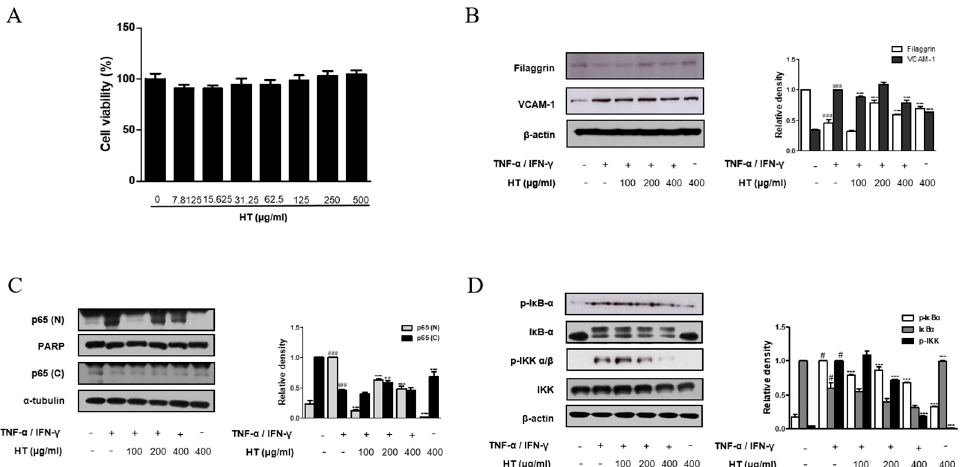
Figure 5. Effect of HT on the expression of filaggrin, VCAM-1 and NF- κ B activation in TNF- α /IFN- γ -stimulated HaCaT keratinocytes. ( A ) HaCaT keratinocytes were incubated with the indicated doses of HT for 24 h, and then cell viability was evaluated by MTT assay. HaCaT keratinocytes were pre-treated with HT for 1 h and then stimulated with TNF- α /IFN- γ (10 ng/mL) for 24 h. Total proteins were prepared and western blotted for ( B ) filaggrin and VCAM-1 using specific antibodies. β -actin was used as internal control. ( C ) Cells were pre-treated with HT for 1 h and then stimulated with TNF- α /IFN- γ (10 ng/mL) for 15, 30 min. Nuclear (N) and cytosol (C) extracts were isolated, and levels of p65 in fractions were determined by western blotting. PARP and α -tubulin were used as internal controls. HaCaT keratinocytes were pre-treated with HT for 1 h and then stimulated with TNF- α /IFN- γ (10 ng/mL) for 5-10 min. Total proteins were prepared and western blotted for ( D ) I κ B- α , and IKK. The data shown represent mean ± S.D. of three independent experiments. # p < 0.05, ### p < 0.001 vs. the control group; ** p < 0.01, *** p < 0.001 vs. TNF- α /IFN- γ -stimulated group.